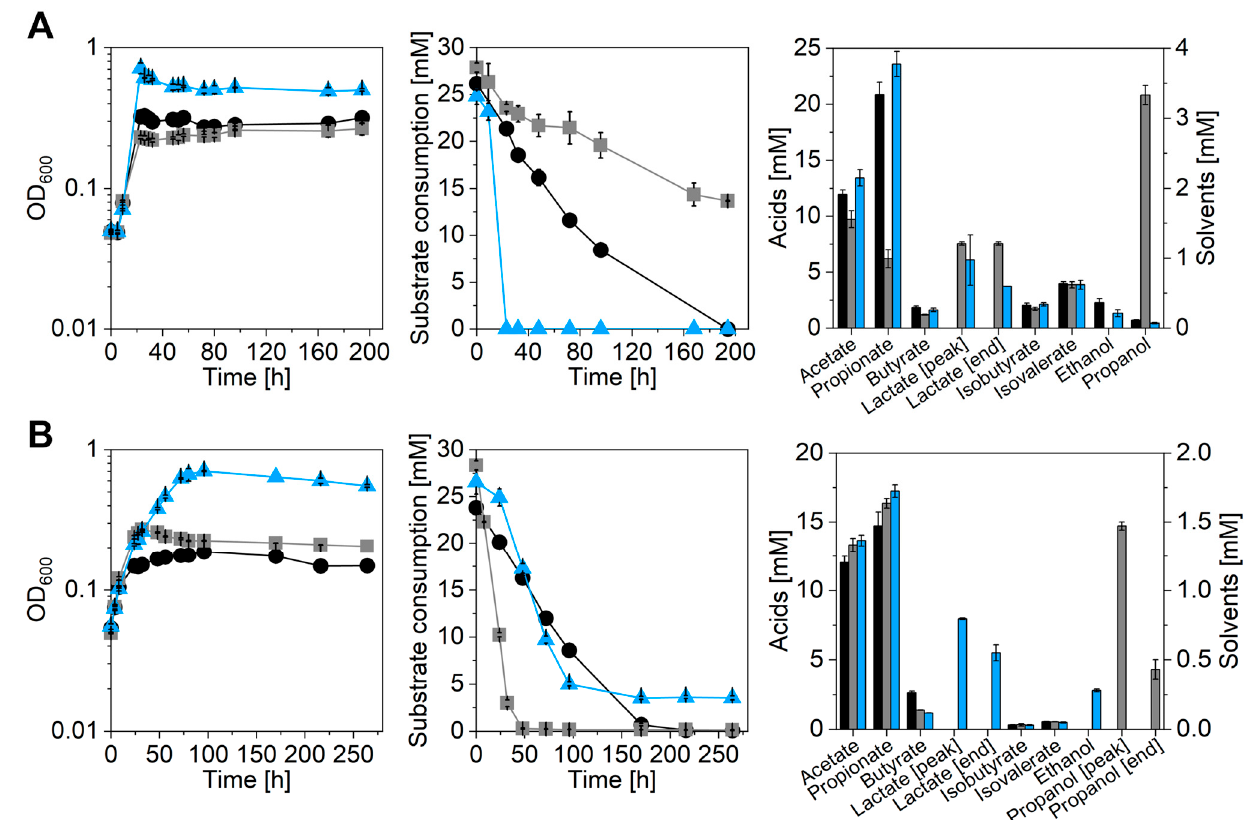
Figure 2. Overview of growth experiments conducted with A. propionicum and A. neopropionicum using different carbon sources. ( A ) Growth (OD 600 , left ), substrate consumption ( middle ), and pro- duct formation ( right ) of A. propionicum ; ( B ) growth ( left ), substrate consumption ( middle ), and product formation ( right ) of A. neopropionicum . Black circles, growth with D -lactate; grey squares, growth with ethanol; blue triangles, growth with L -alanine ( A. propionicum ) or xylose ( A. neopropio- nicum ). Error bars represent standard deviations, n = 3.